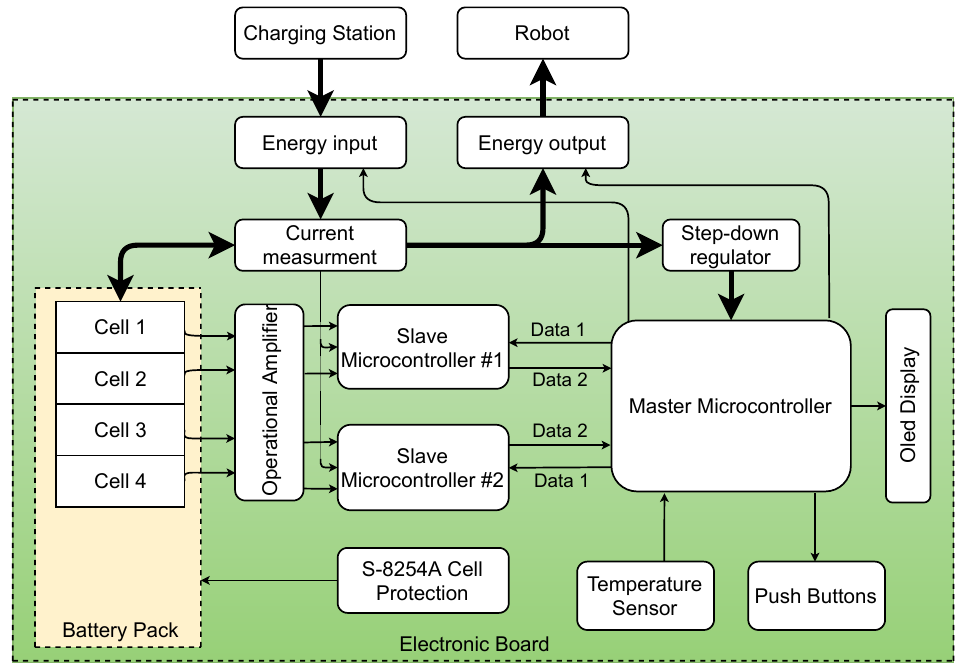
Figure 2. System block